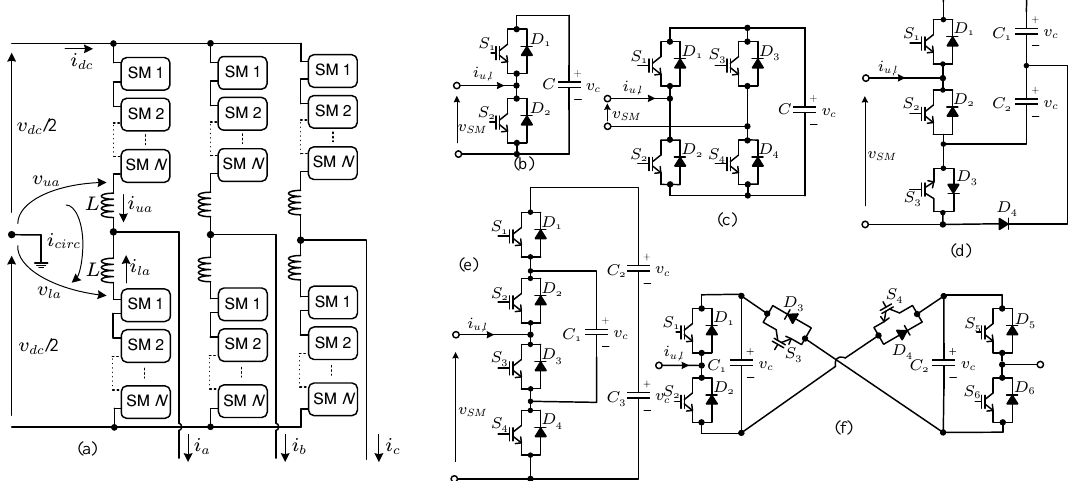
Figure 1. MMC: ( a ) Three-phase circuit configuration; ( b ) Half-bridge (HB)-SM; ( c ) Full-bridge (FB)-SM; ( d ) Single-clamped (SC)-SM; ( e ) Flying-capacitor (FC)-SM; ( f ) Cross-connected